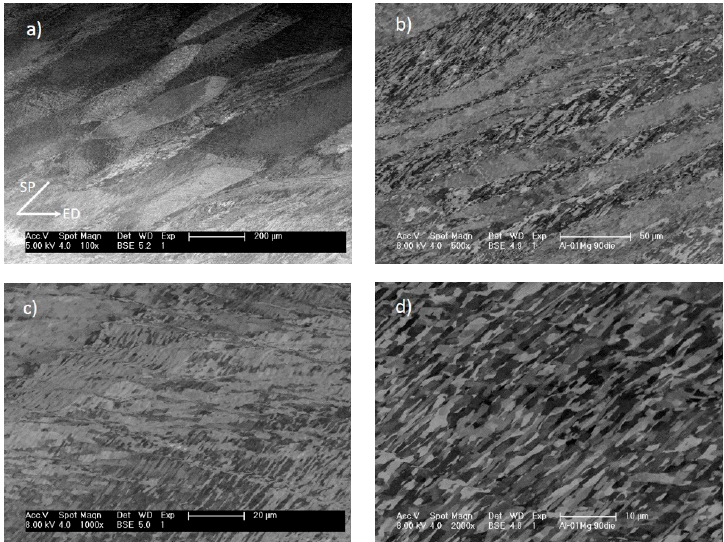
Figure 2. FEG ‐ SEM back scattered images, showing features of characteristic deformation structures after the 1st pass with the 90° die: ( a ) overall elongated microstructure; ( b ) primary deformation bands; ( c ) secondary deformation bands; ( d ) aligned cell bands. ED—the extrusion direction; SP—the die shear plane. Metals 2016 , 6 , 158